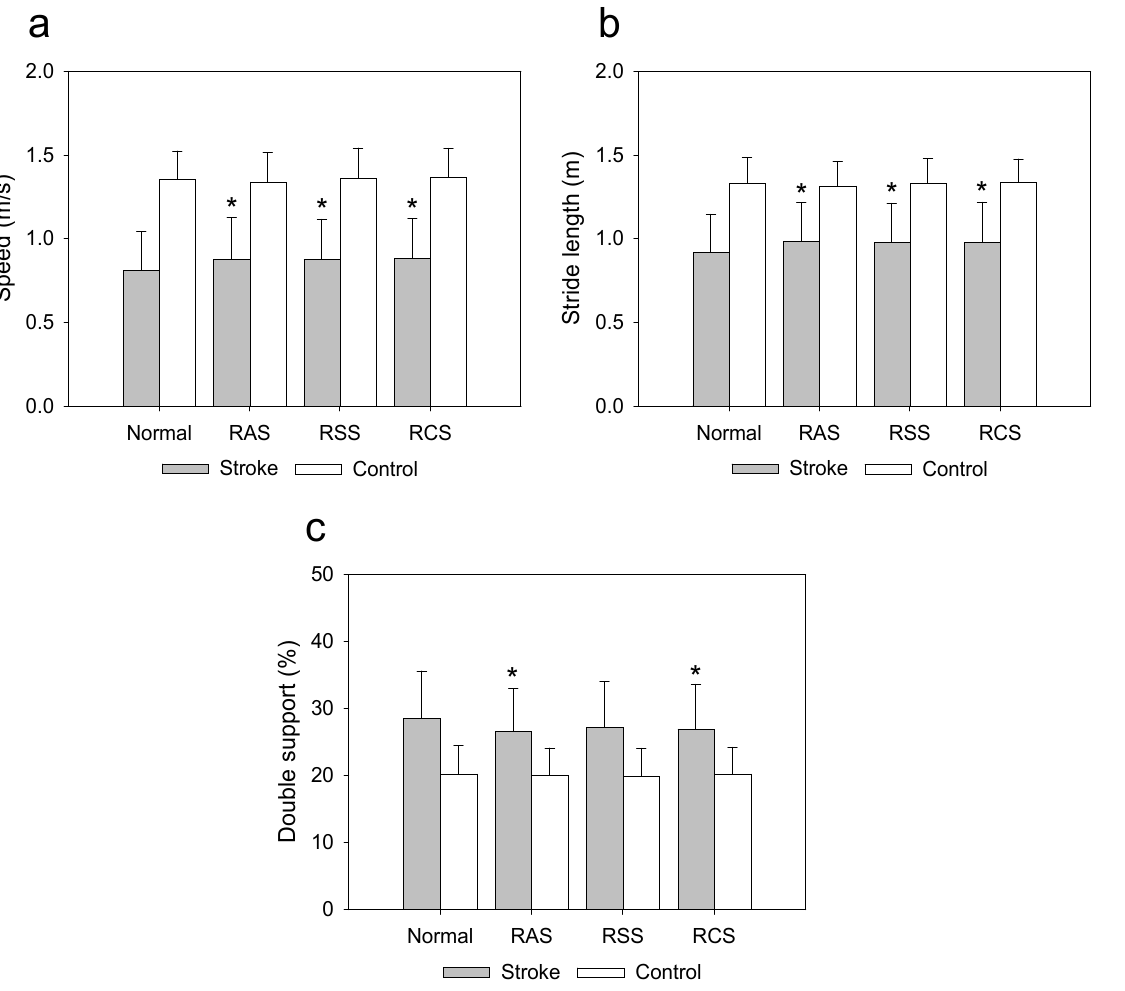
Figure 4. Effects of rhythmic sensory stimulation on gait performance compared to normal walking: ( a ) speed; ( b ) stride length; ( c ) double support. Normal: no stimulation; RAS: rhythmic auditory stimulation; RSS: rhythmic somatosensory stimulation; RCS: rhythmic combined stimulation (RAS + RSS); * indicates significant difference compared to normal condition ( p < 0.008).